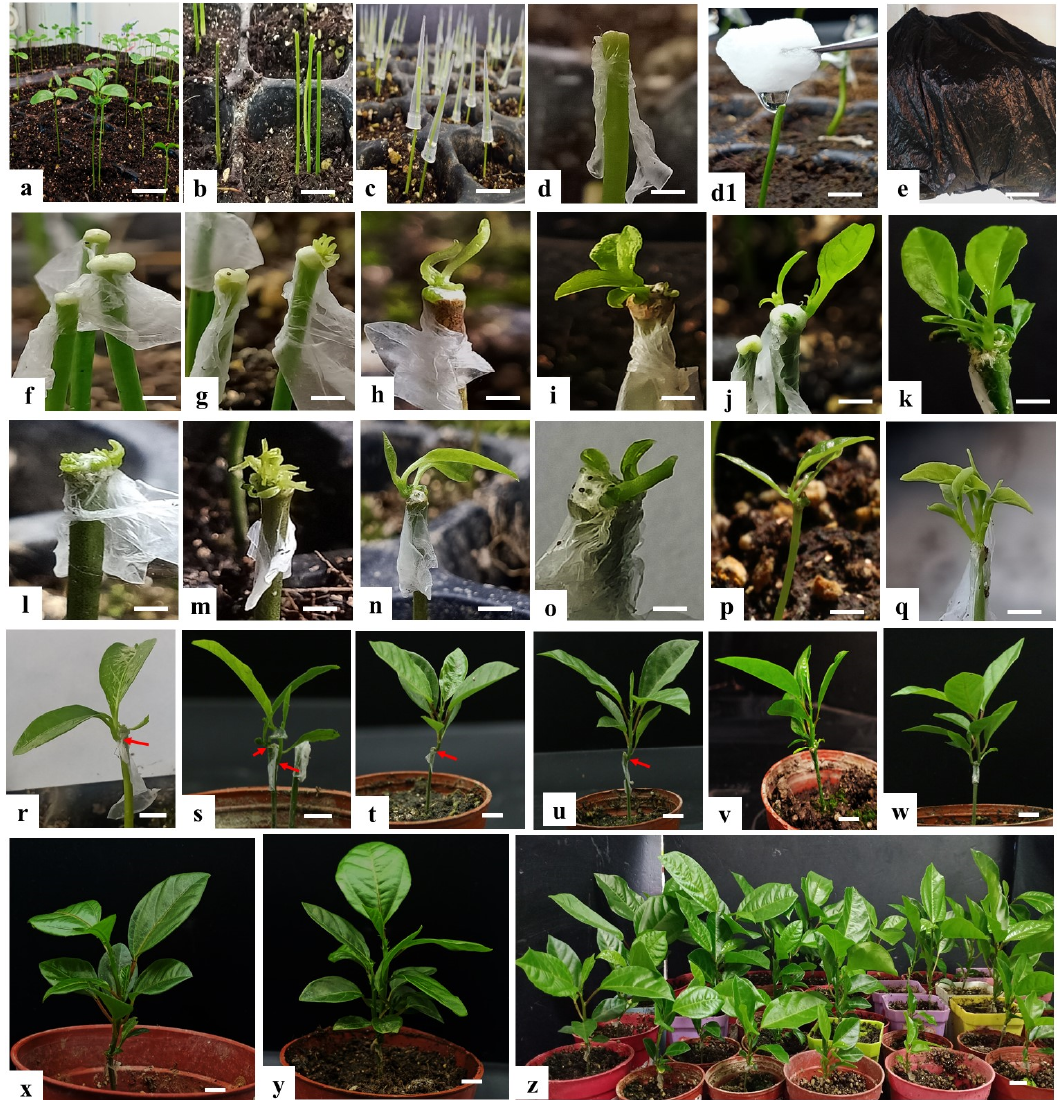
Figure 1. Procedure of Agrobacterium-medicated in planta transformation for passion fruit ( Passiflora edulis ). ( a ) Two–three weeks old passion fruit seedlings; ( b ) decapitated passion fruit seedlings; ( c ) Agrobacterium infection on the decapitated seedling wounded site; ( d ) wounds of Agrobacterium infected seedlings were wrapped with Parafilm; ( d1 ) wounds of transformed seedlings were gently immersed in cotton balls saturated with 100 mg L − 1 hygromycin for two to three times as selection marker/screening; ( e ) seedlings were kept under a black sheet for 15 days as dark incubation; ( f ) callus formed on wounded site; ( g ) buds sprouting from the newly formed callus; ( h ) single bud sprouted from the callus; ( i ) single bud elongated after 5 weeks of screening, sprouted from callus; ( j ) multiple buds sprouted from callus; ( k ) multiple buds elongated after 5 weeks of screening culture, sprouted from callus; ( l , m ) buds sprouting directly from xylem or regeneration occurs by direct organogenesis (without callus formation); ( n ) regeneration of single bud by direct organogenesis; ( o ) regen- eration of multiple buds by direct organogenesis; ( p ) single bud elongated after 5 weeks of screening culture, regenerated by direct organogenesis; ( q ) multiple buds elongated after 5 weeks of screening culture, regenerated by direct organogenesis; ( r ) regenerated shoot from side of decapitated seedling; ( s ) regenerated shoots from side and below the decapitated seedling wounded spots; ( t ) regenerated shoot from side of decapitated seedling wound, after 3 months of screening culture; ( u ) re- generated shoot below the decapitated seedling wound, after 3 months of screening culture; ( v ) single shoot elongated after 3 months of screening culture; ( w ) multiple shoots elongated after 3 months of screening culture; ( x ) single shoot elongated after 5 months of screening culture; ( y ) multiple shoots elongated after 5 months of screening culture; ( z ) regenerated shoots from callus and without callus after 5 months of screening culture. (Scale bar = 1